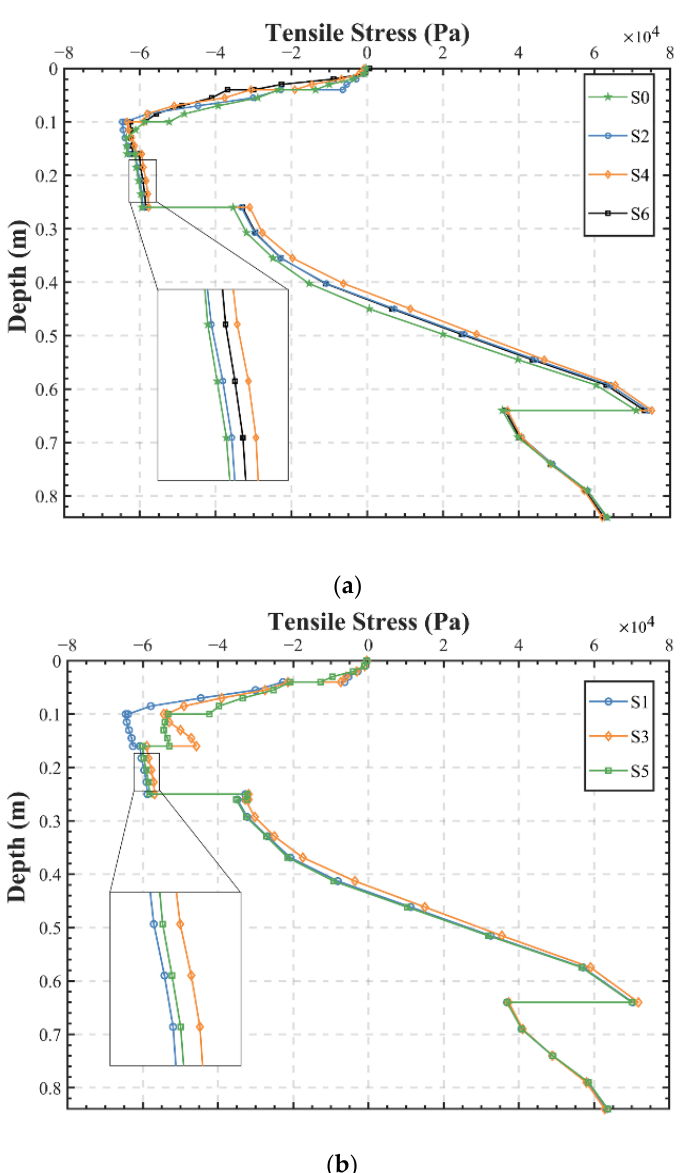
Figure 8. Pavement stress along depth: ( a ) S0, S2, S4, and S6; ( b ) S1, S3, and S5.